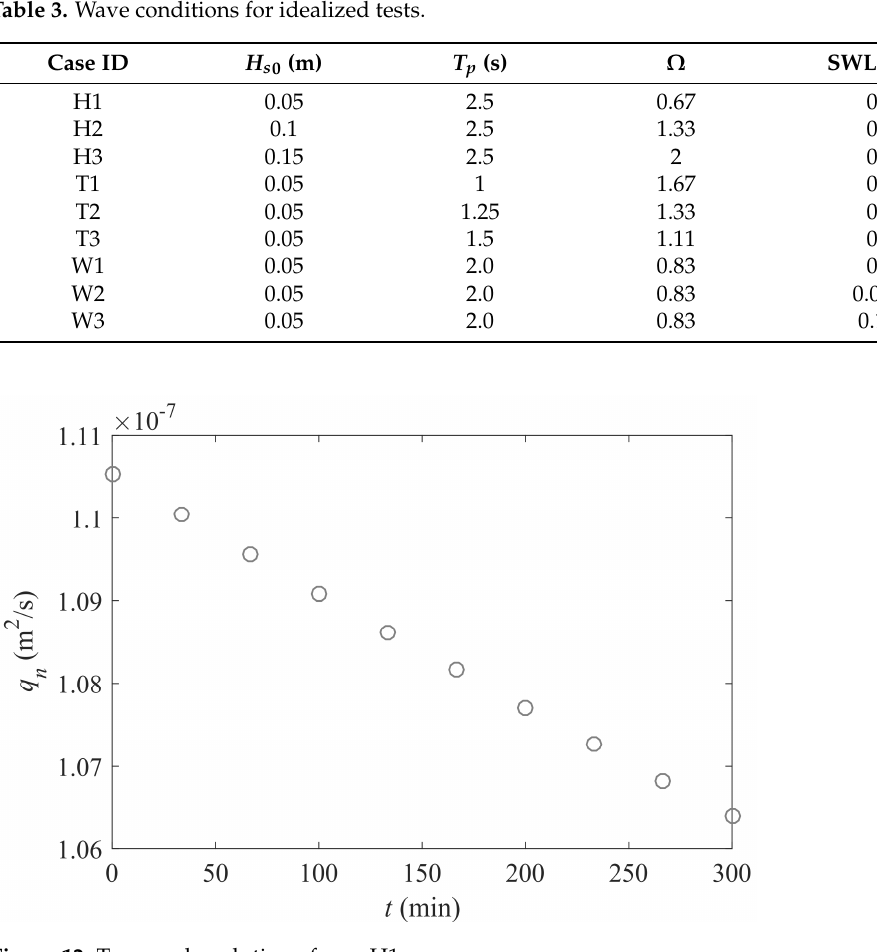
Table 3. Wave conditions for idealized tests.